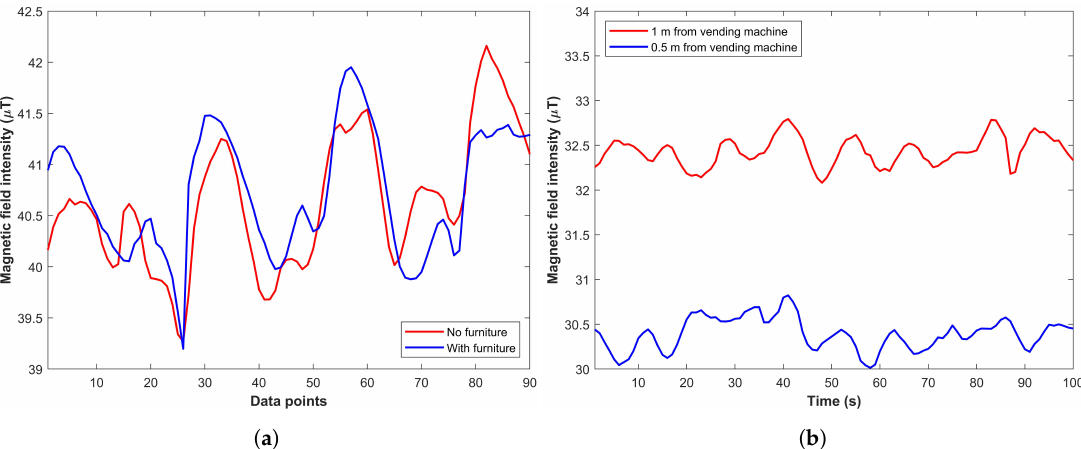
Figure 8. The impact of ferromagnetic materials’ proximity, ( a ) Influence of furniture, and ( b ) Vending machine